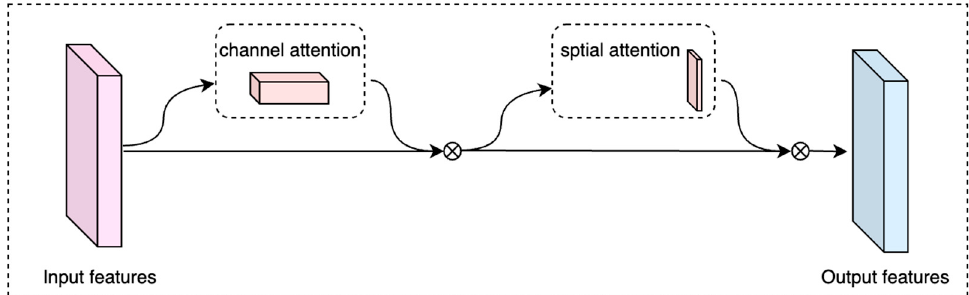
Figure 7. The structure of CBAM (Convolutional Block Attention Module).